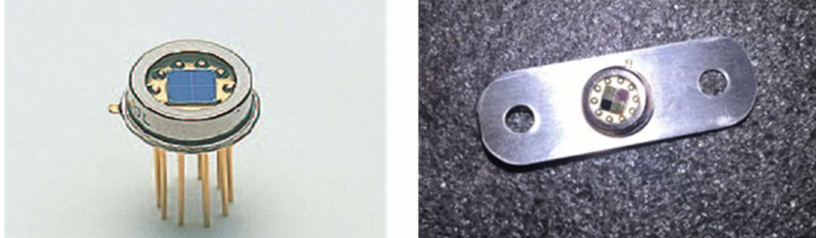
Figure 6. Commercial quad-array detector ( left ) and after three active area arrays are covered with different multivariate optical elements (MOEs) fabricated on Kapton tape ( right ).